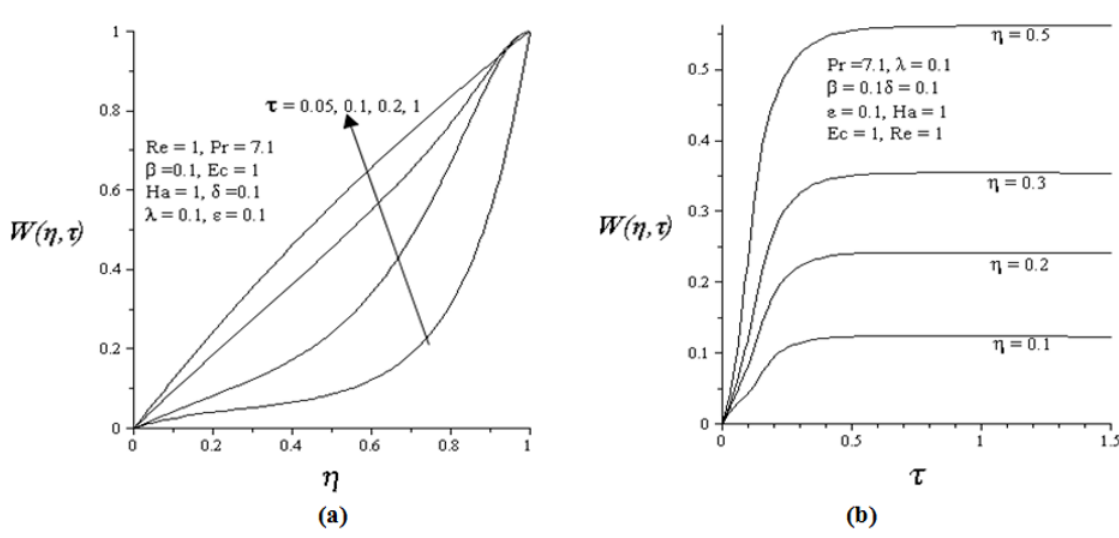
Figure 3. Fluid velocity profiles across the channel with increasing time